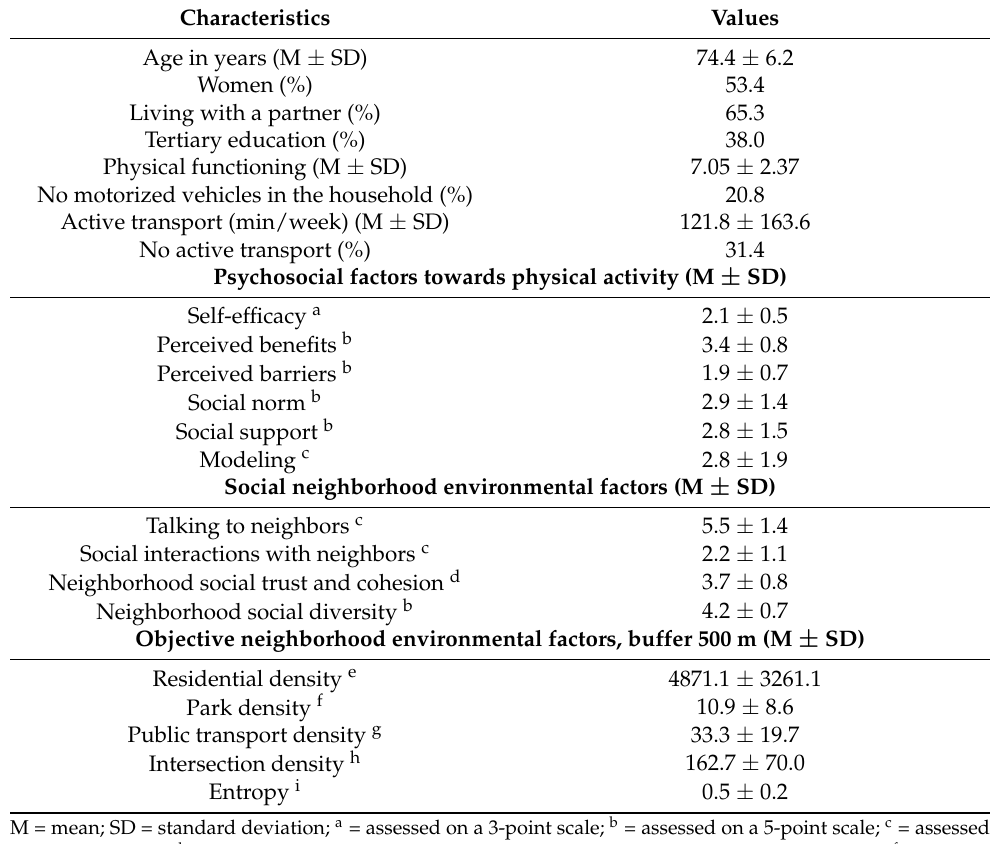
Table 1. Descriptive statistics of the participants ( n =